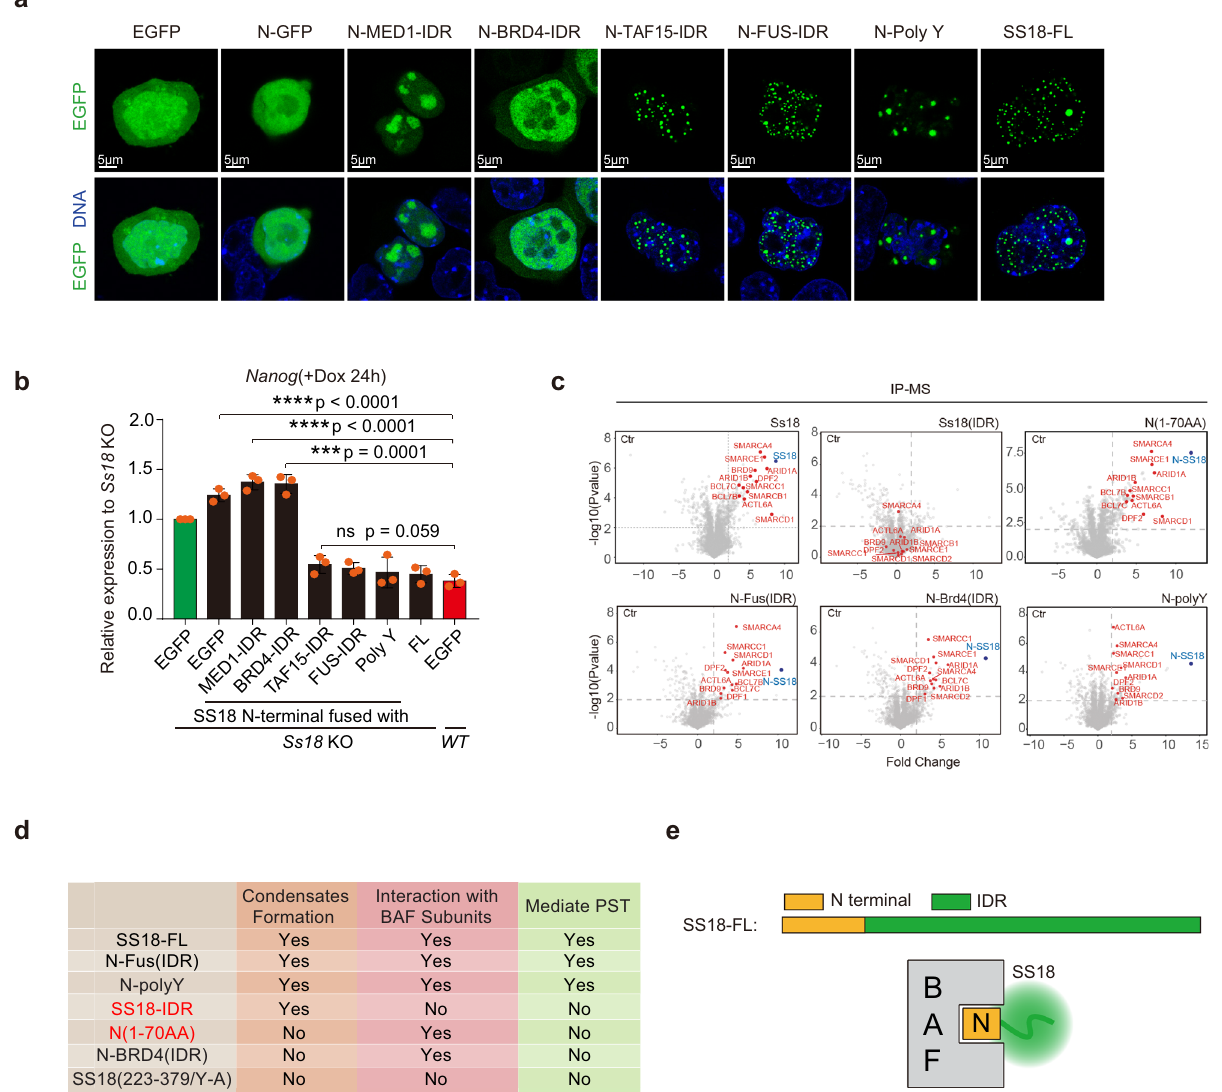
Fig. 5 SS18 interacts with BAF through its N-terminal 70 residues. a Representative images for EGFP fusions expressed in mESCs as indicated. Note the similar condensates formed by SS18, FUS and TAF IDRs as compared to those for MED1 and BRD4. Poly Y is an arti fi cial 24 tyrosine residue polypeptide. FL full length. Scale bars, 5 μ m. laser intensity 2.5%, detector gain 500 V, background subtraction treatment. Three biological replicates. b Rescue of Ss18KO by constructs in ( a ) to show that IDRs from TAF and FUS or even polyY can substitute that of SS18. Data are mean ± s.d., two-sided, unpaired t test; n = 3 independent experiments, *** p < 0.001, **** p < 0.0001. c Volcano plots of IP-MS results from fl ag tagged Ss18-FL, SS18(IDR), N terminal 70aa of Ss18 alone or fused with IDRs from FUS or Brd4 and polyY expressed in Ss18KO mESCs by Flag antibody with label-free quanti fi cation. Every point represents a single protein. SS18 and BAF components are marked in blue and red, respectively. IP-MS experiments were performed in triplicates and a two-sample t test was applied. P = 0.01 and fold change = 2 were used as threshold. d Summary table for various constructs for their abilities to condensate, interact with BAF and mediate PST. e A proposed structure and function relationship for SS18: N-terminal BAF interacting domain or BID and C-terminal condensate forming IDR domain